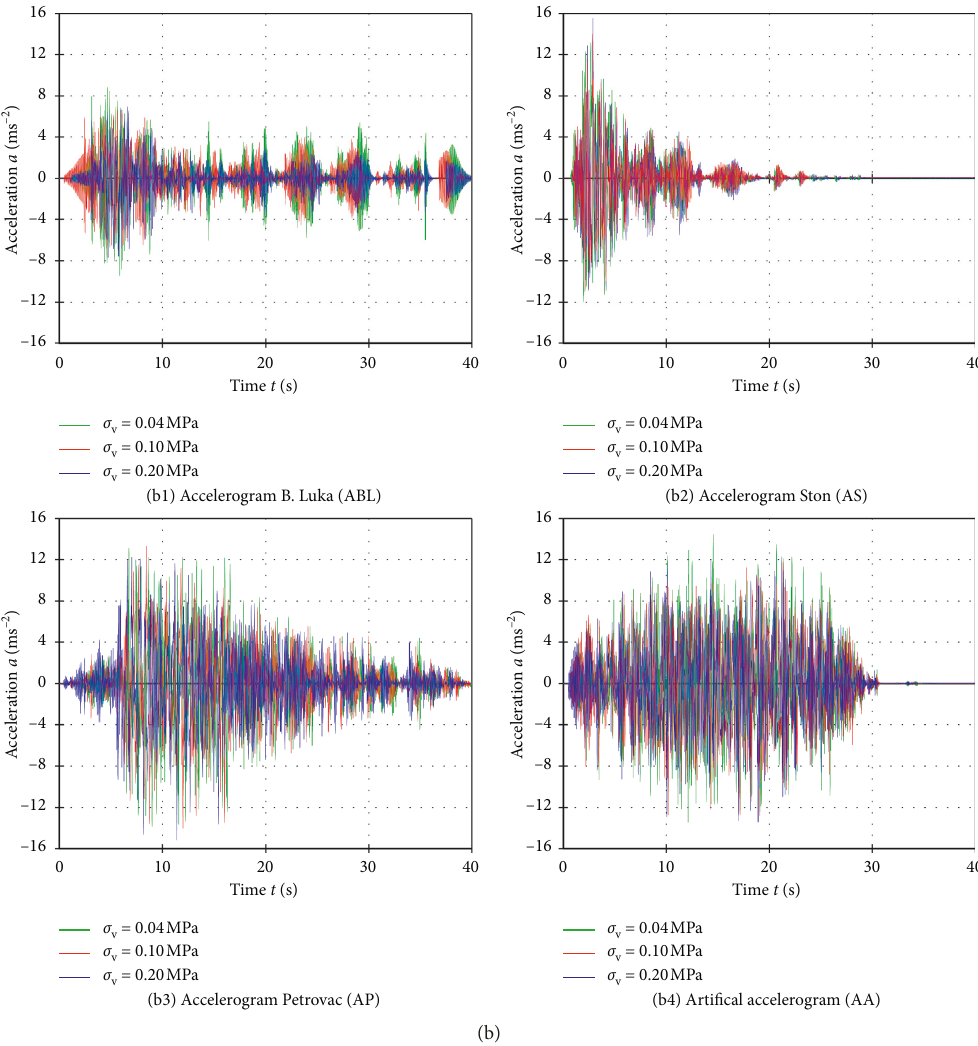
Figure 26: The effect of vertical contact stress below the foundation on horizontal acceleration a . (a) PGA � 0.2g. (b) PGA �